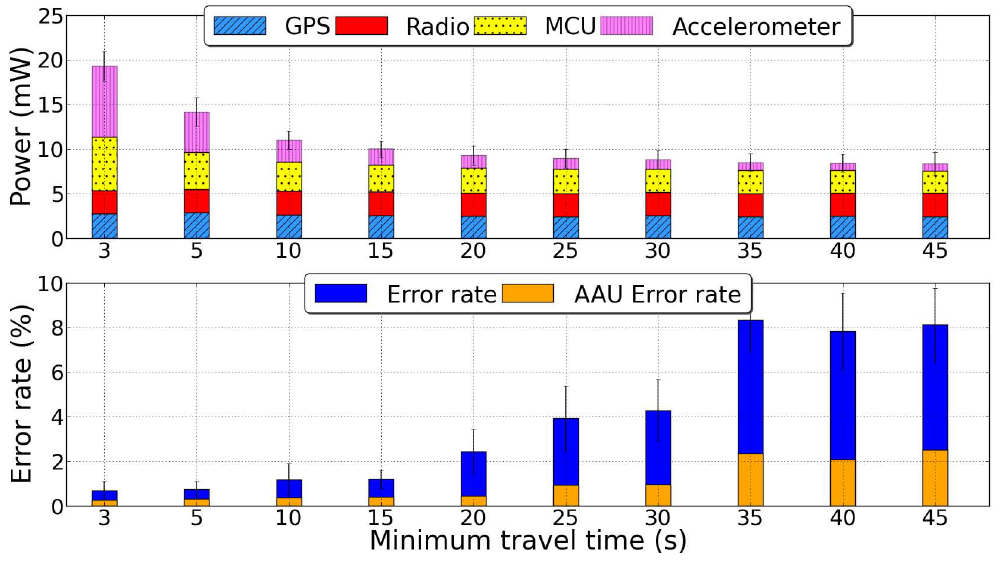
Figure 8. The impact of varying T M on node energy consumption and error rates. The AAU error rate refers to the errors observed in the online algorithm, while the error rate refers to all the errors based on ground truth positions.